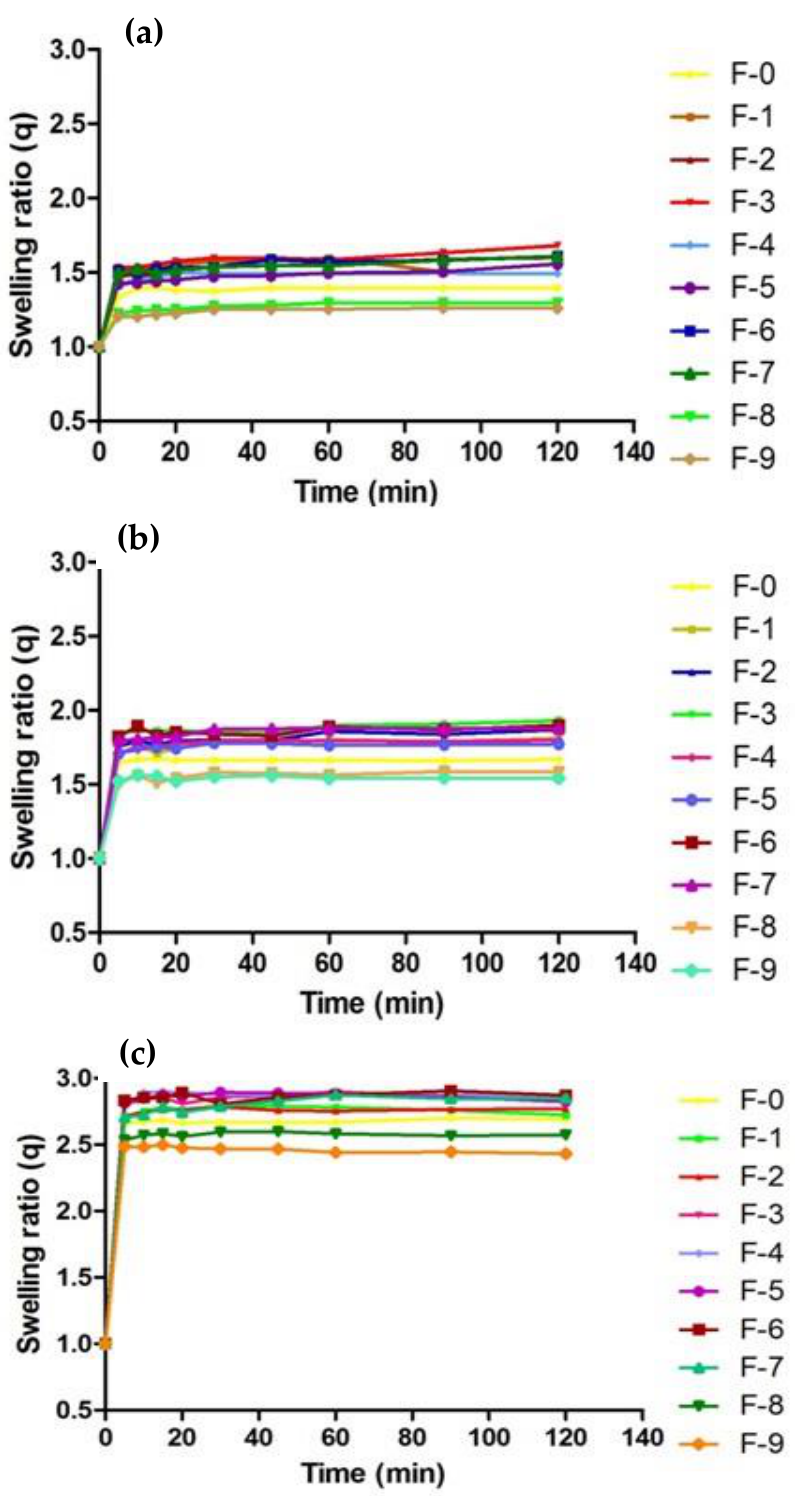
Figure 8. ( a ) Swelling ratio of developed nanosponges (F0 – F9), in buffer solution of pH 1.2, ( b ) pH 4.5, and ( c ) pH 6.8.